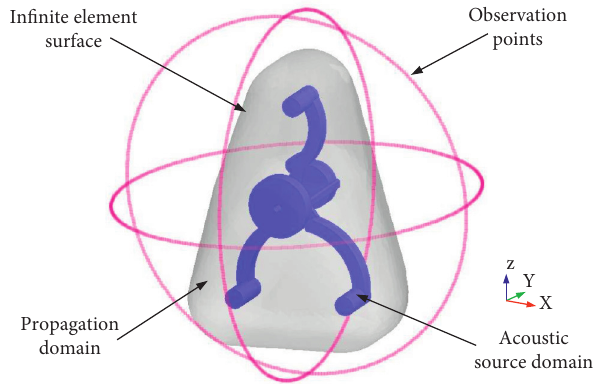
Figure 9: Computational acoustic